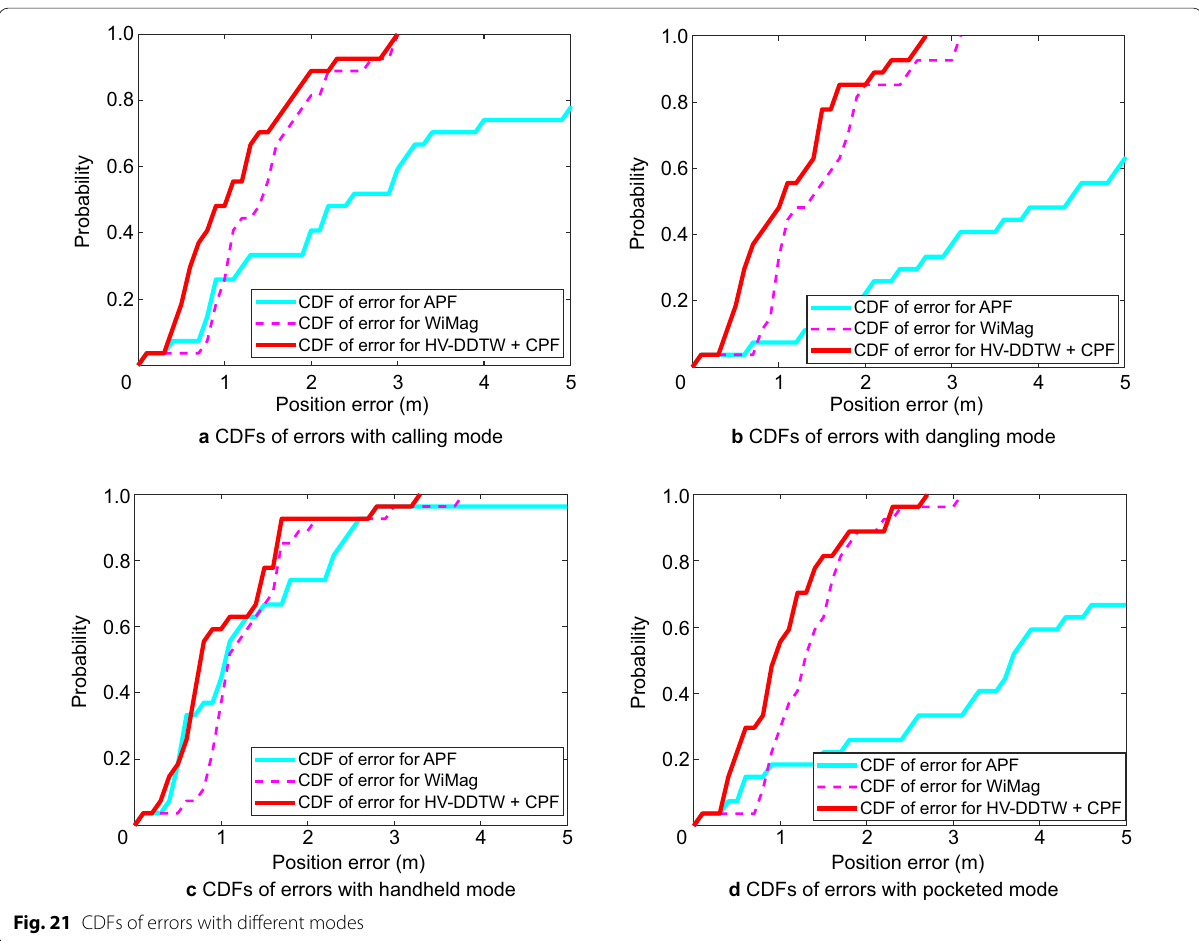
Fig. 21 CDFs of errors with different modes